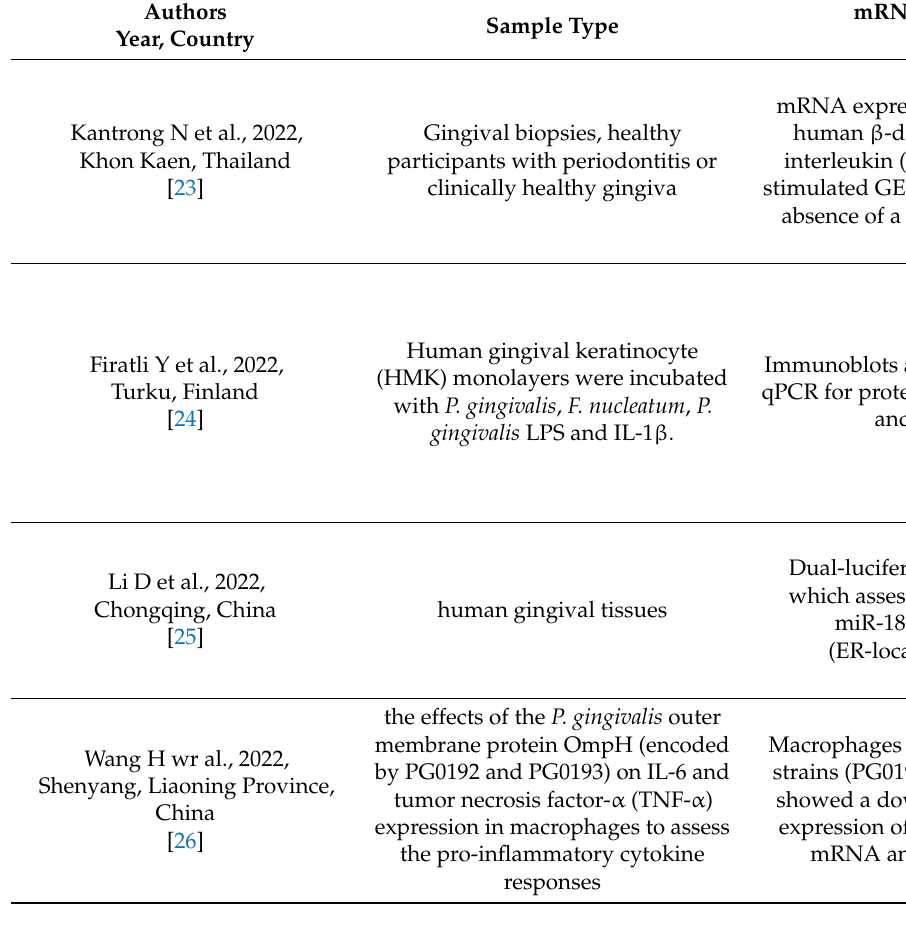
Table 1. Associations between periodontal disease and Porphyromonas gingivalis by mRNA